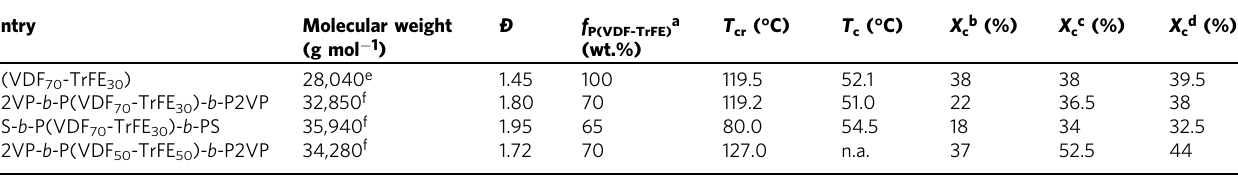
Table 1 Molecular characterization data for P(VDF-TrFE) and its block copolymers